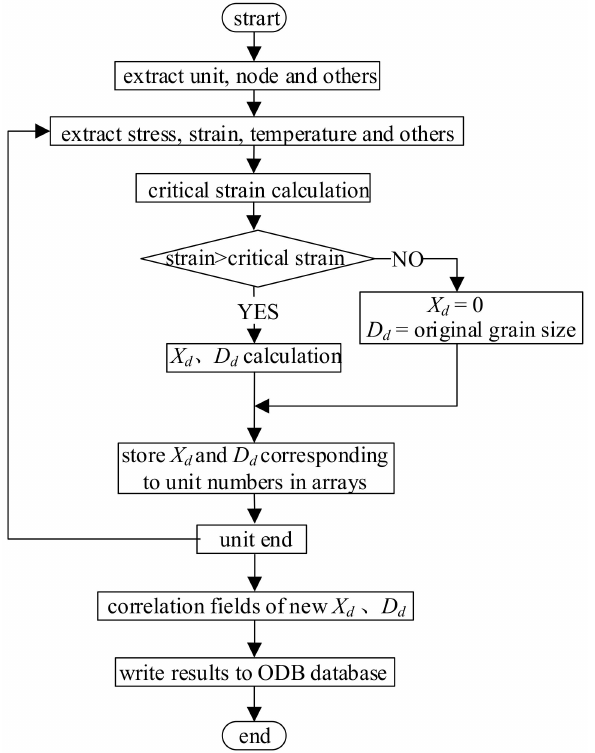
Figure 6. Program flow